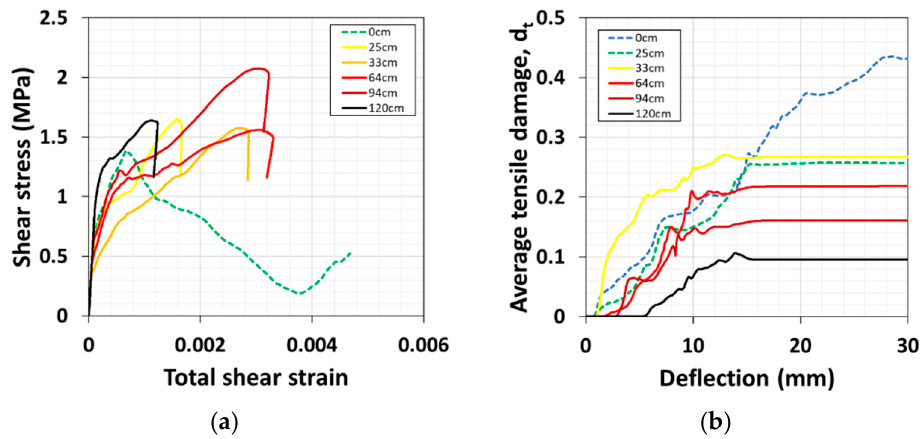
Figure 11. ( a ) Shear stress–strain plots, and ( b ) Tensile damage index-deflection plots at the various monitoring lines (0, 250, 330, 640, 940, and 1200 mm).